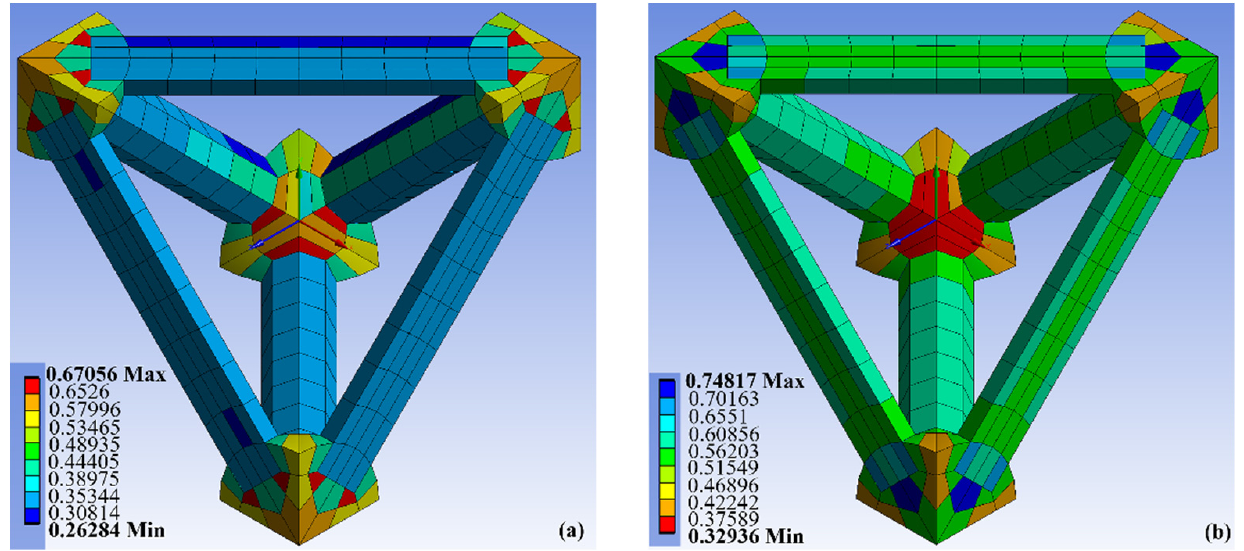
Figure 10. ( a ) Mesh element quality, where values closer to 1 are desired; ( b ) Mesh skewness, where values closer to 0 are desired. Table 1. Basic mesh settings used in Ansys Table 1. Basic mesh settings used in Ansys Mechanical.